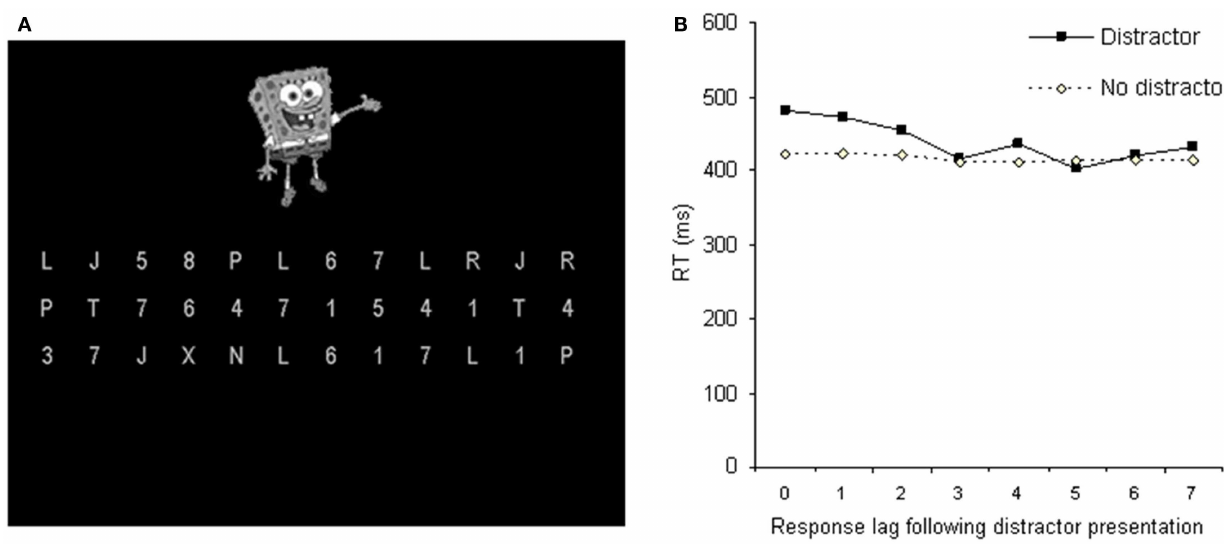
FIGURE 2 |A continuous task designed to preclude general attentional settings associated with the onset of the display . (A) Example stimulus display: participants make sequential responses, working from left to right, top to bottom, indicating whether each item in the display is a letter or a digit.The display remains onscreen throughout the response sequence.The distractor appears briefly during a minority of